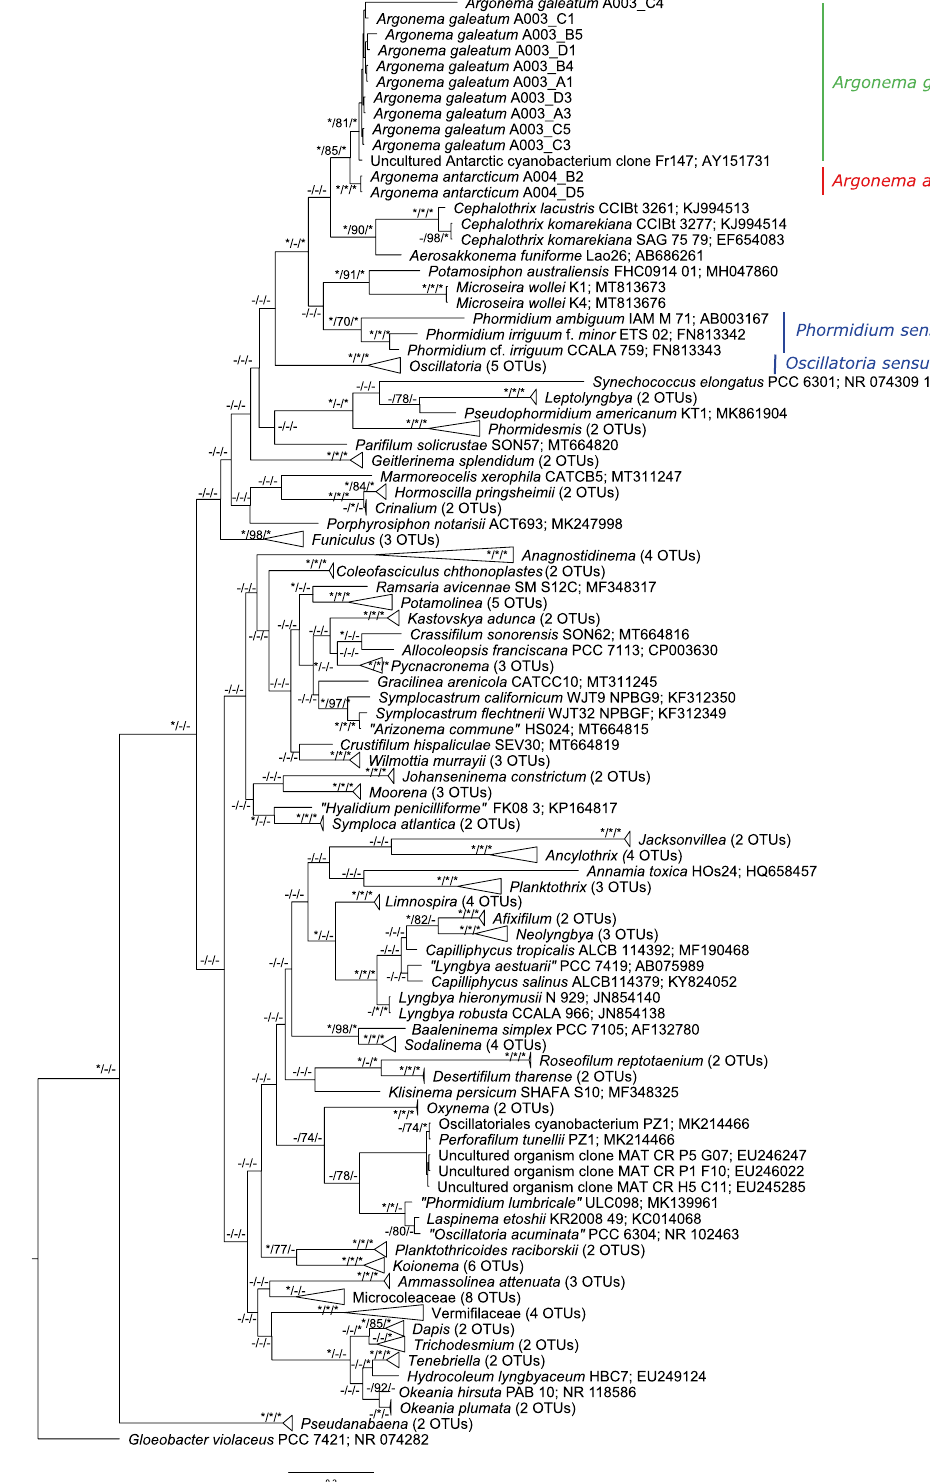
Figure 12. Phylogenetic reconstruction of Argonema based on 16S rRNA. The phylogenetic tree was constructed using Bayesian inference. Node labels represent node supports; Bayesian inference/maximum parsimony/maximum likelihood. Nodes with a support of 99 or 100 are marked with a star and supports below statistical significance are marked with a